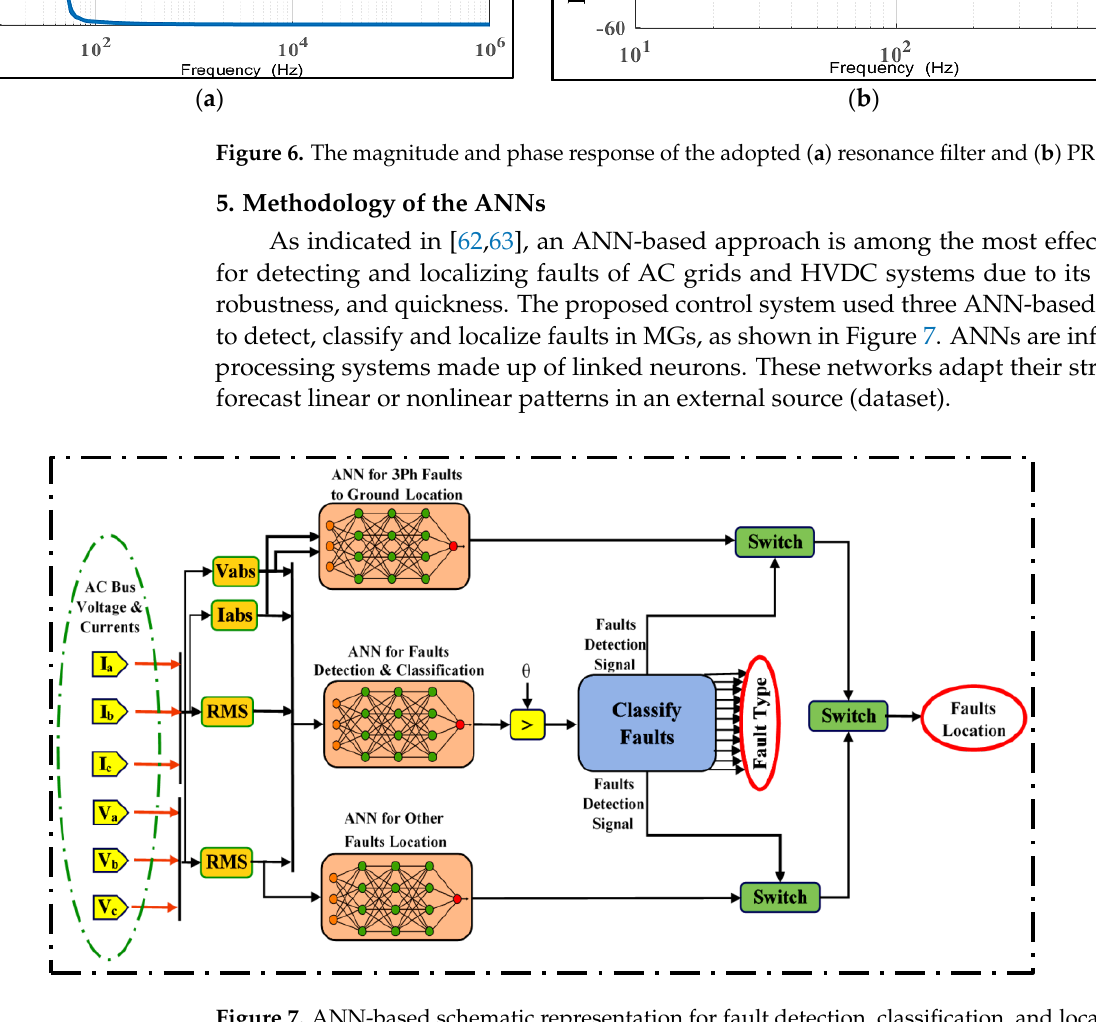
Figure 6. The magnitude and phase response of the adopted ( a ) resonance filter and ( b ) PR control- ler.